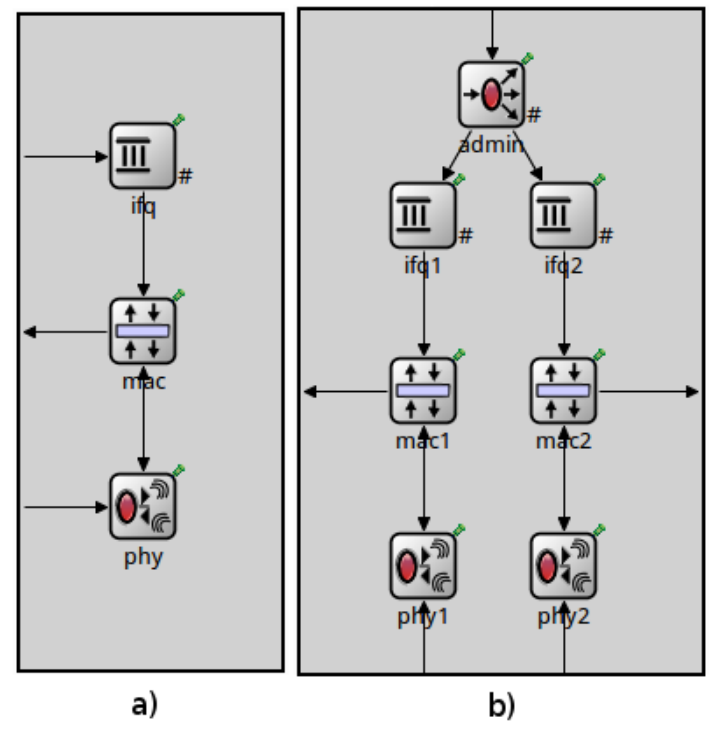
Figure 5. ( a ) single-radio NIC module; ( b ) multi-radio NIC